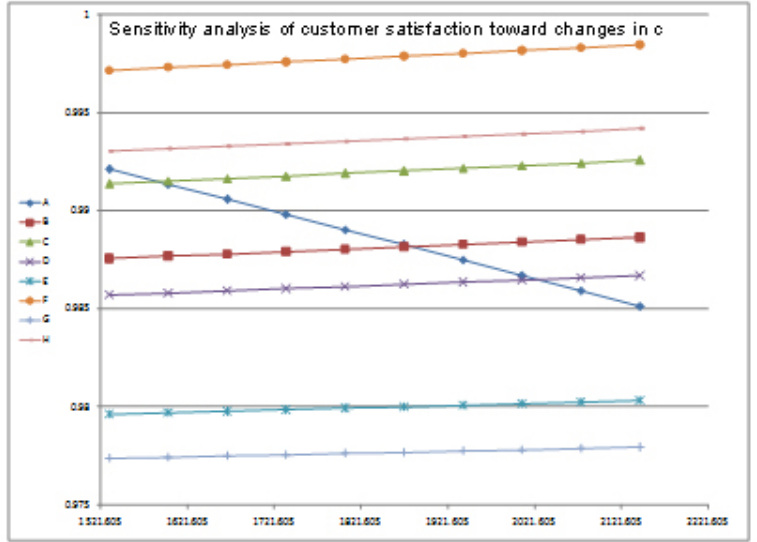
Fig.2. Change in customer satisfaction in respect to changes in manufacturing costs for manufacturer A in Nash equilibrium 7. Case study of game theory based on competition in supply chain with n manufacturers- common retailer (simultaneous)